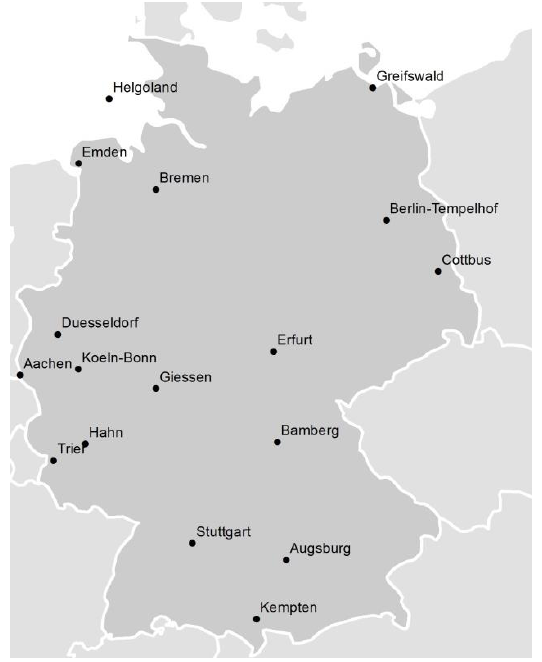
Figure 1. Weather stations used for BiomeBGC